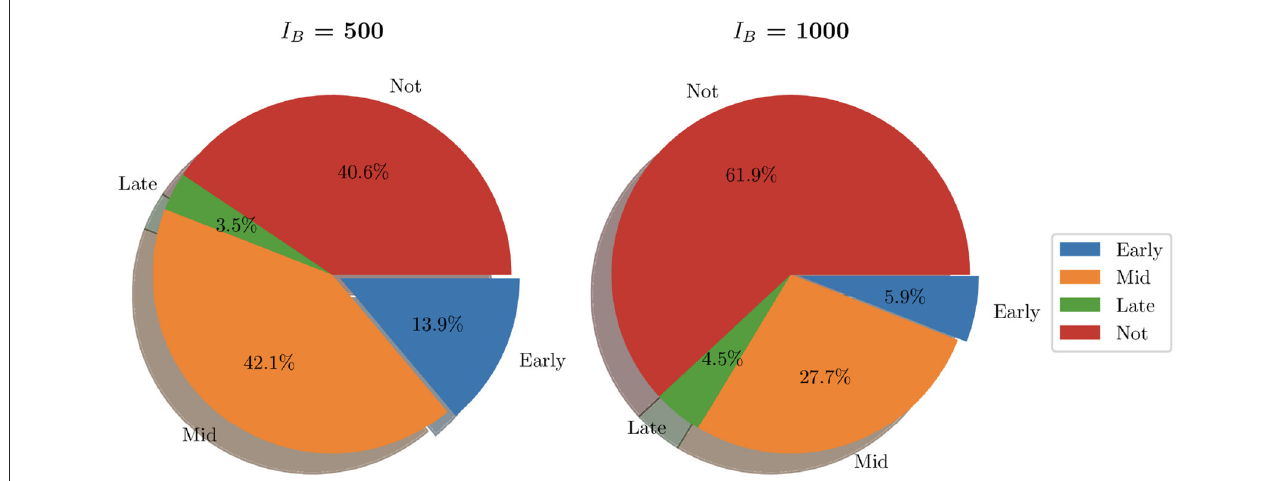
h, as the bacterial count of high I B begins to decline due to clearance by neutrophils and helper macrophages that have arrived at the site of infection. While in contrast, a low I B allows bacteria to maintain a steady growth within the interval 2 < t < 6 h. Once 9 < t < 14 h, all simulations converge closely. The final bacterial load of the early stage, N t = 15 , matches in order of initial bacterial count except for B I B = 1 which has managed to overtake I B = 100. Although the trend appearing from the early stages of infection seems to indicate possible bacterial clearance, once we look at the later stages of the